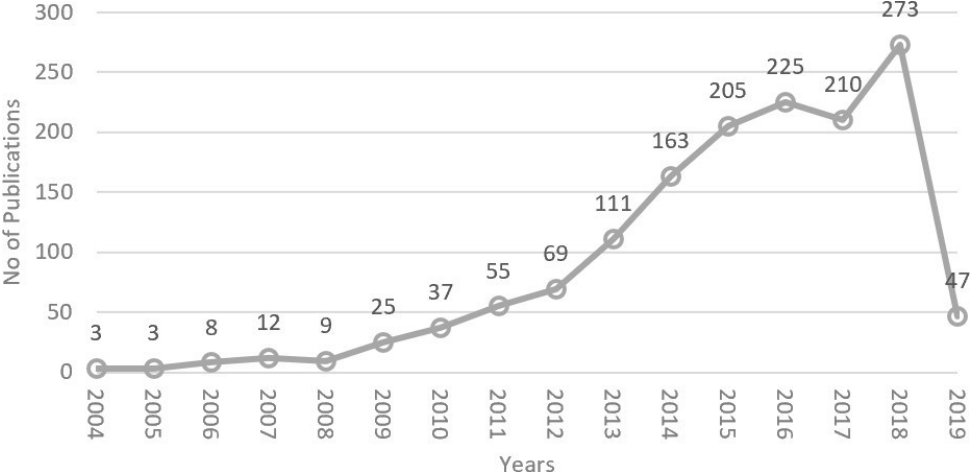
Figure 3. Distribution of BIM publications with times.